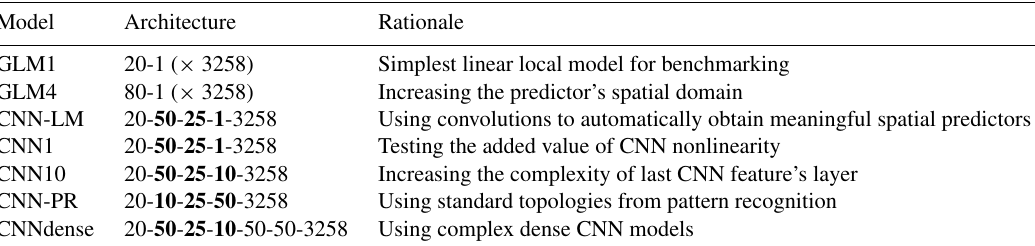
Table 2. Description of the deep learning architectures intercompared in this study, together with the two benchmark methods: GLM1 and GLM4 (these models are trained separately for each of the 3258 land-only grid boxes in E-OBS). Convolutional layers are indicated with boldfaced numbers. The numbers indicating the architecture correspond to the number of neurons in the different layers (in bold for convolutional layers).